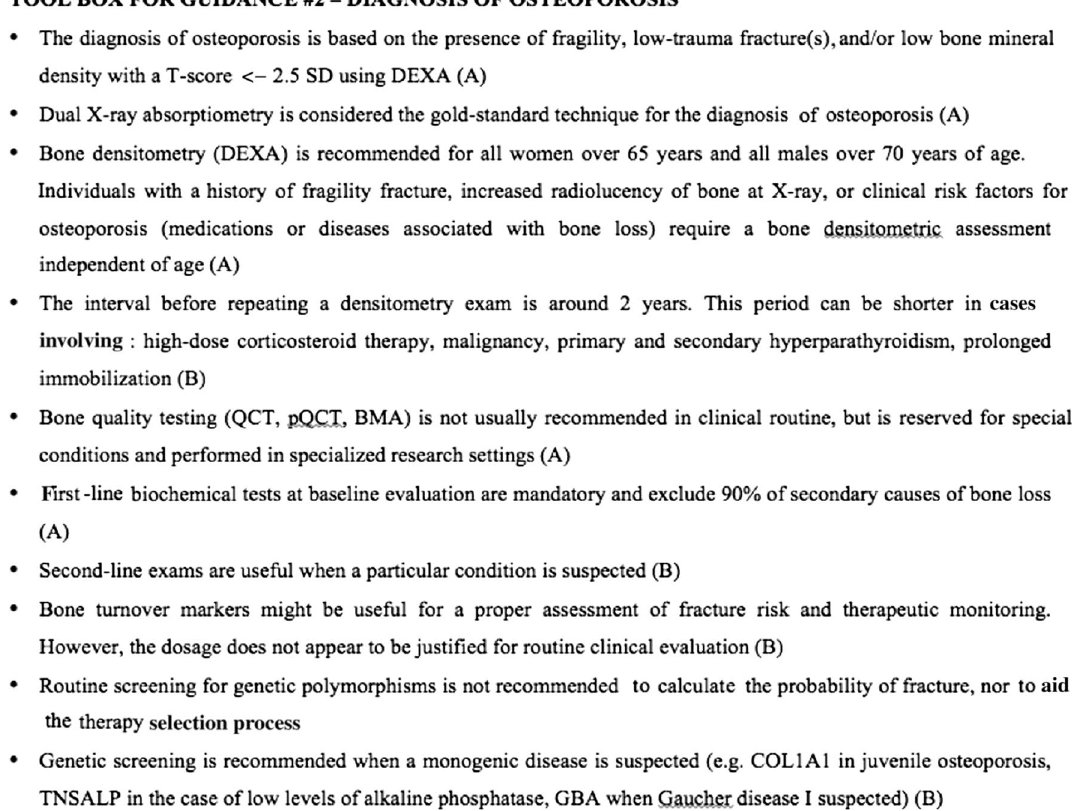
Fig. 2 Toolbox for guidance: diagnosis of